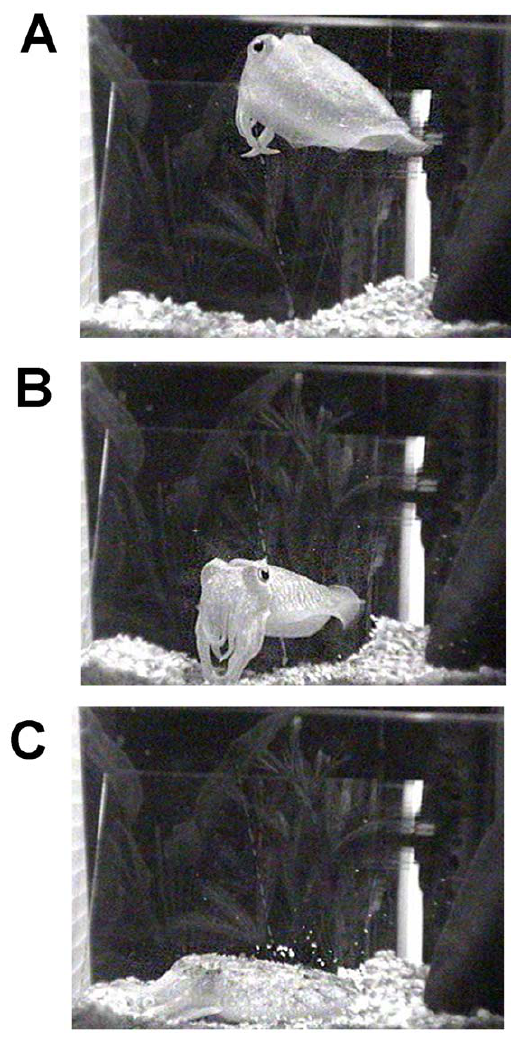
Figure 1. States of arousal and quiescence in the cuttlefish Sepiaofficinalis . Cuttlefish exhibit clear periods of activity where the animals actively swim (A) or hover (B) and periods of quiescence (C) where they lie on the surface or are partly buried in gravel bedding with closed eyes. An adult/senescent animal is shown.